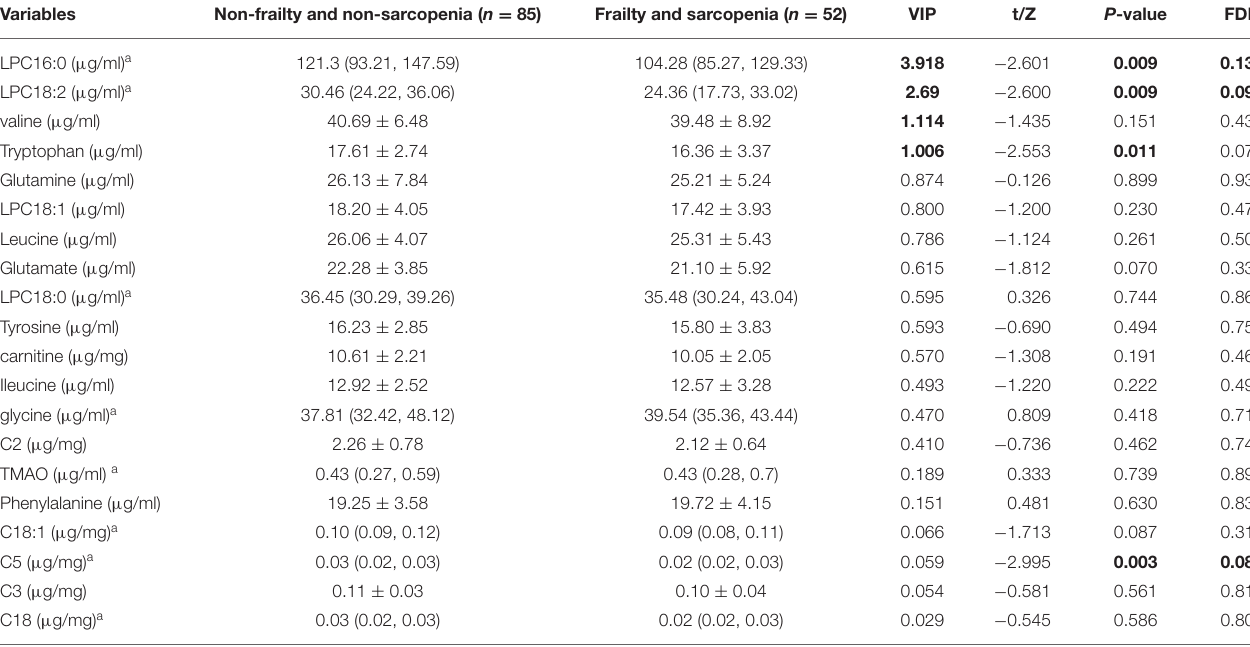
TABLE 4 | Serum concentrations of discriminant analytes in frailty and sarcopenia (F&S). Variables Non-frailty and non-sarcopenia ( n = 85) Frailty and sarcopenia ( n = 52) VIP t/Z P